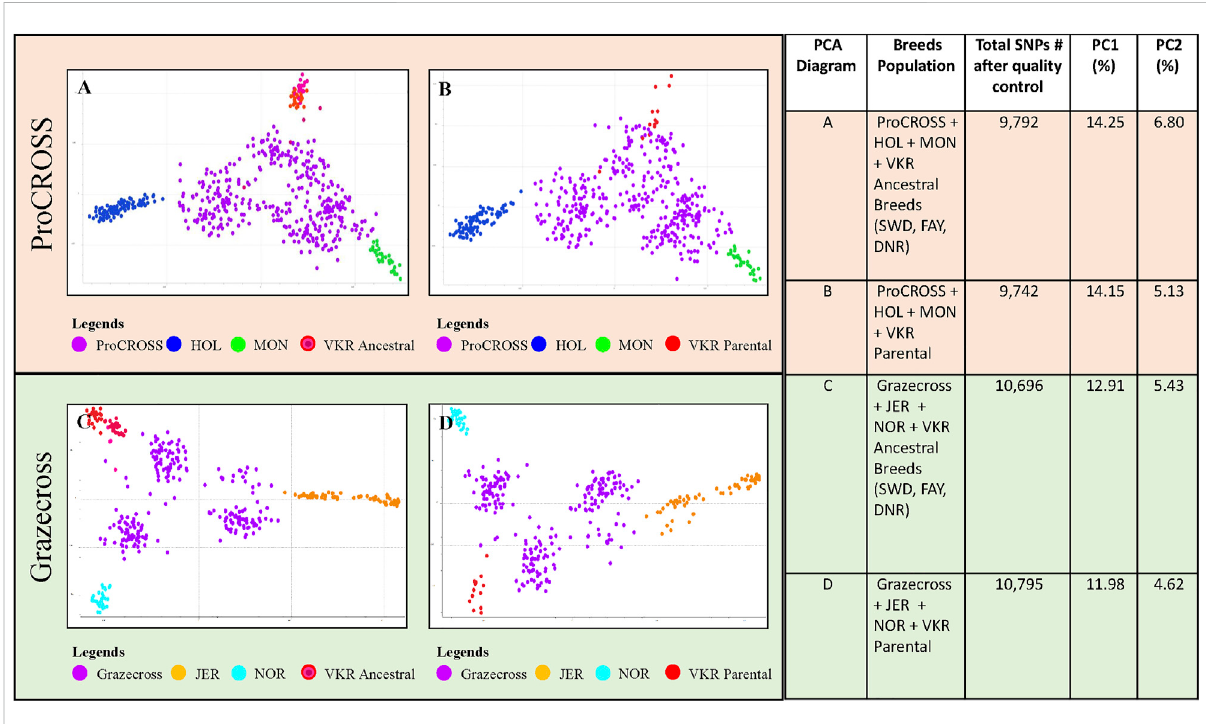
FIGURE 1 PrincipalcomponentanalysiscomparingadmixedpopulationsofProCROSSandGrazecrosswiththeirancestralbreeds.Thetopdiagrams (A,B) depictProCROSSwithancestralpopulationsofHOL,MON,andVKR.Thebottomdiagrams (C,D) depictGrazecrosswithancestralpopulationofJER, NOR, and VKR. Left-hand diagrams (A,C) use the ancestral breeds of SWD, FAY and DNR to represent VKR. The right-hand diagrams (B,D) use commercial VKR sires used in the ProCROSS and Grazecross populations to represent VKR. The right-hand table shows the number of SNPs used for the PCA with the percentage of variation described by principal components 1 ( X -axis) and 2 ( Y -Axis) for each